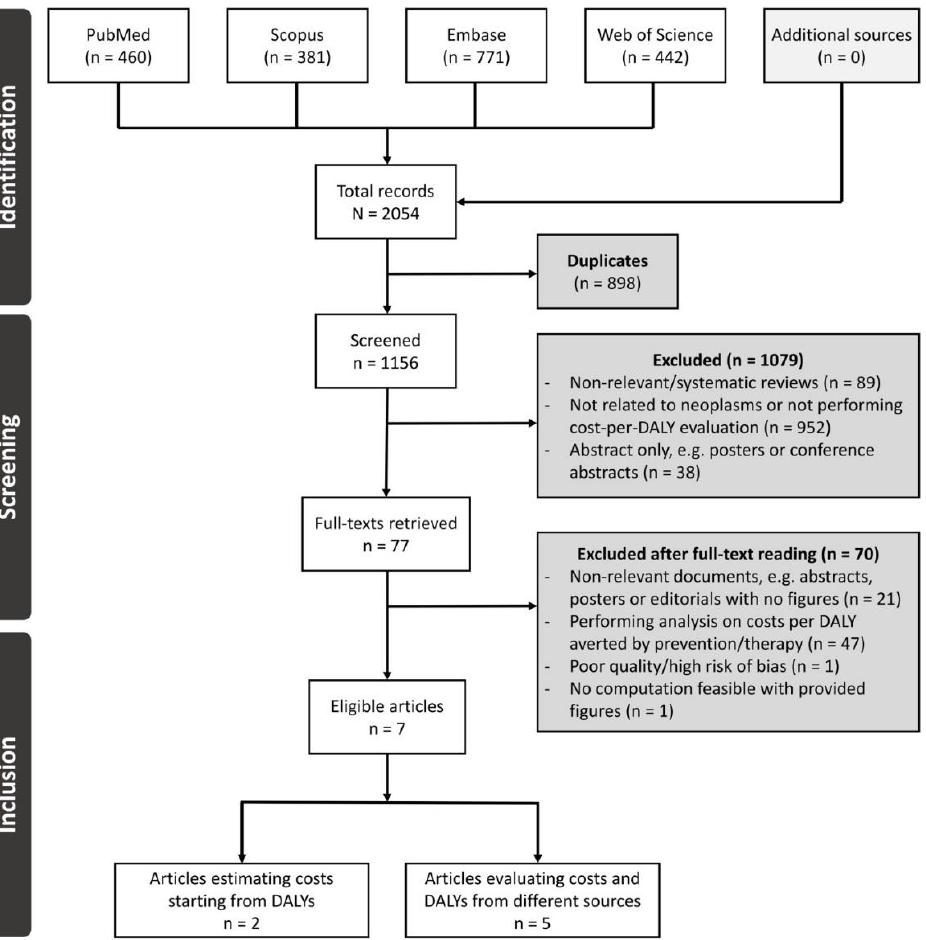
Figure 1. Study selection flow-chart according to the PRISMA Standard.